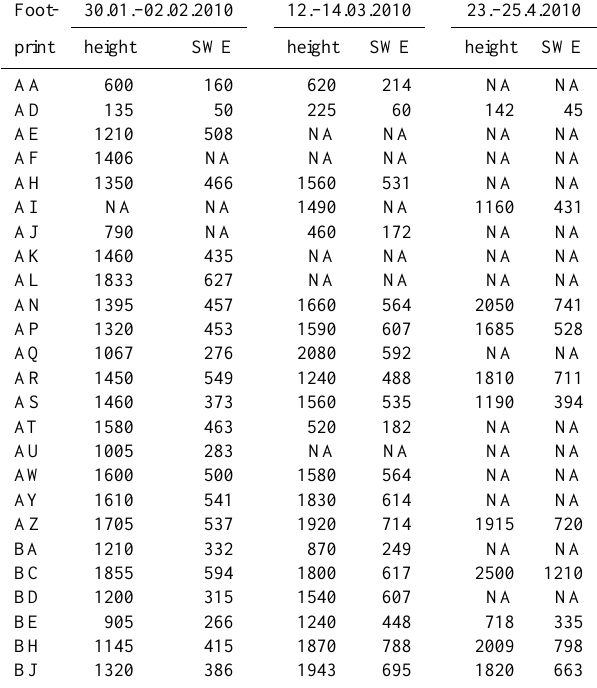
Table 1. Snow measurements from winter 2009/10, all values are in mm. Snow heights are based on 10 randomly chosen measure- ment points. SWE was measured in the centre of each footprint and adapted accordingly to the mean